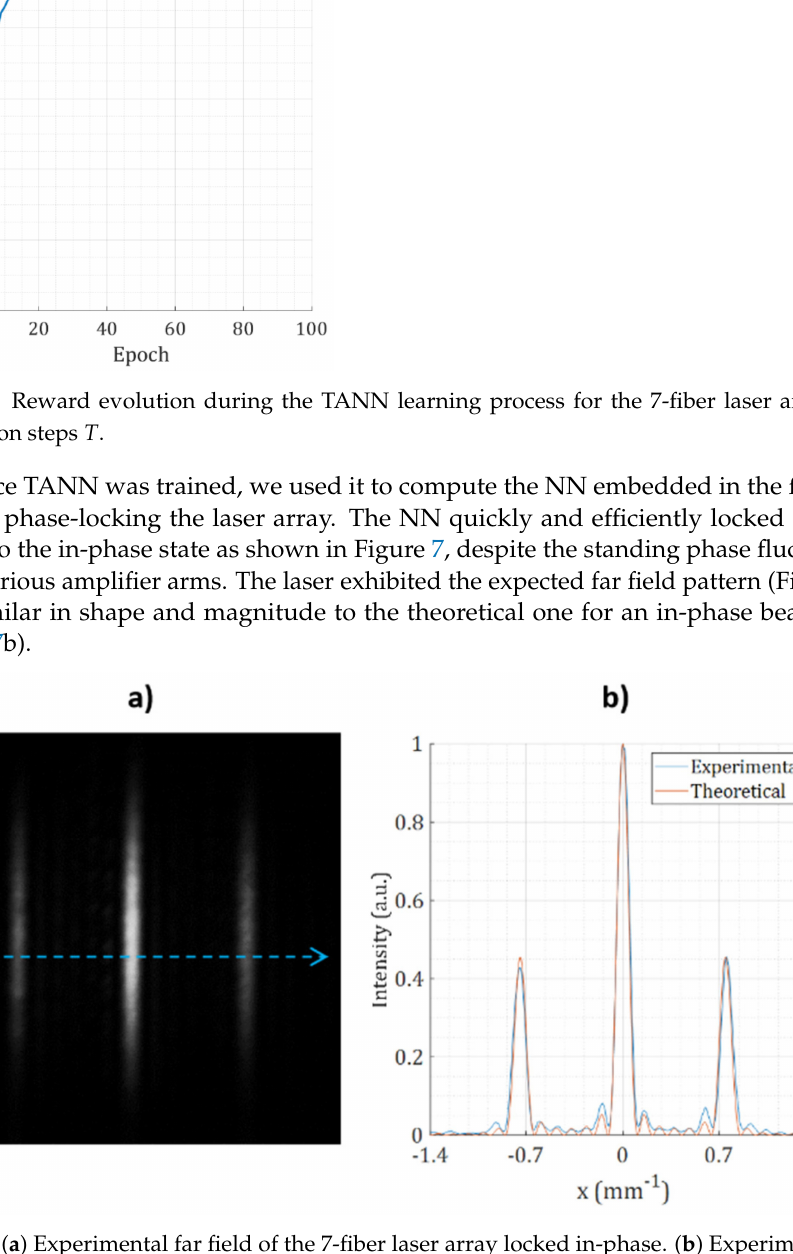
Figure 7. ( a ) Experimental far field of the 7-fiber laser array locked in-phase. ( b ) Experimental and theoretical profiles of the phase-locked fiber laser